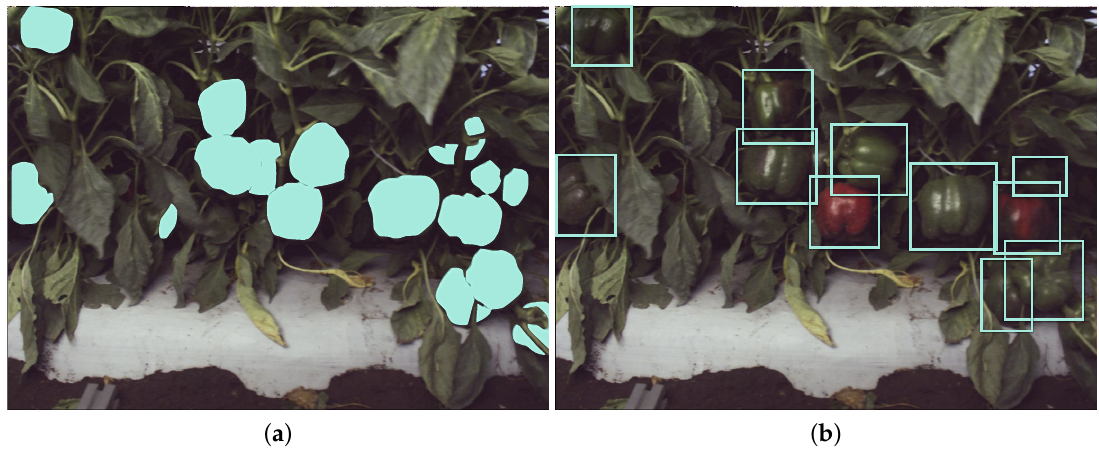
Figure 2. Pixel-wise ( a ) and bounding box ( b ) image